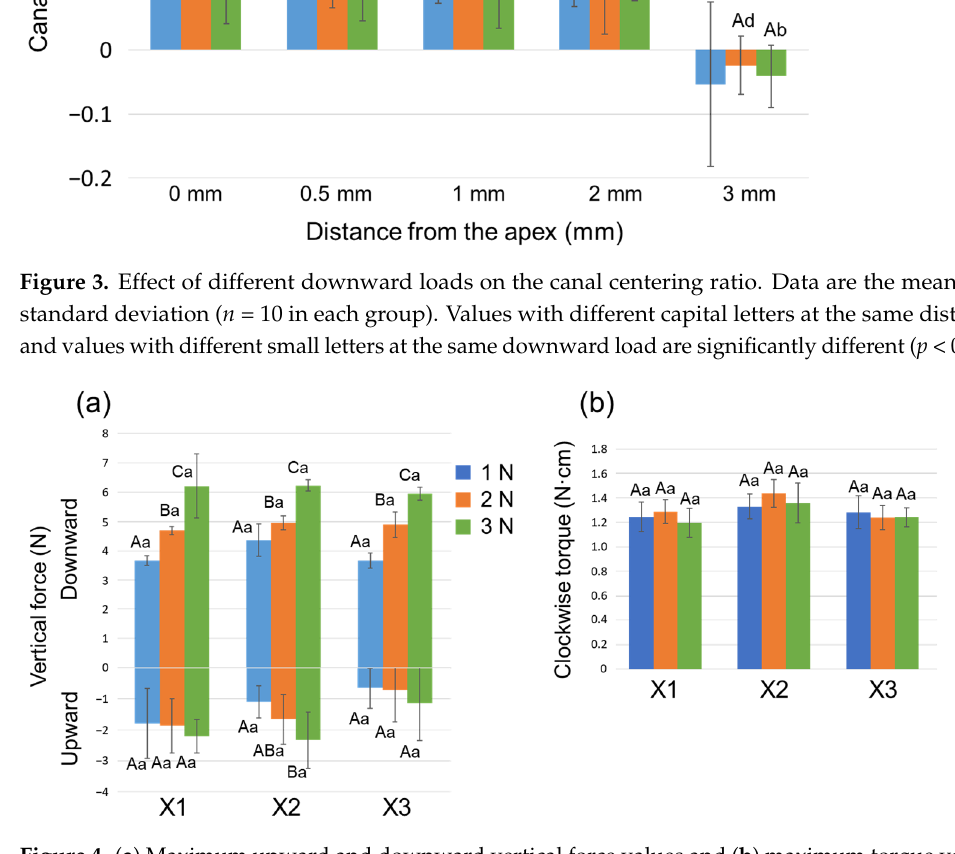
Figure 3. Effect of different downward loads on the canal centering ratio. Data are the mean and standard deviation ( n = 10 in each group). Values with different capital letters at the same distance and values with different small letters at the same downward load are significantly different ( p < 0.05).